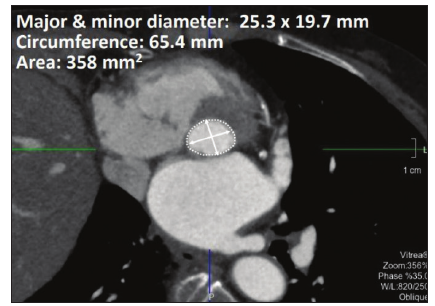
Figure 5. Multidetector computed tomography angiography measurement of the aortic annular diameter, showing the major and minor orthogonal diameters, as well as the perimeter and cross-sectional area, computed by the workstation after manual contour